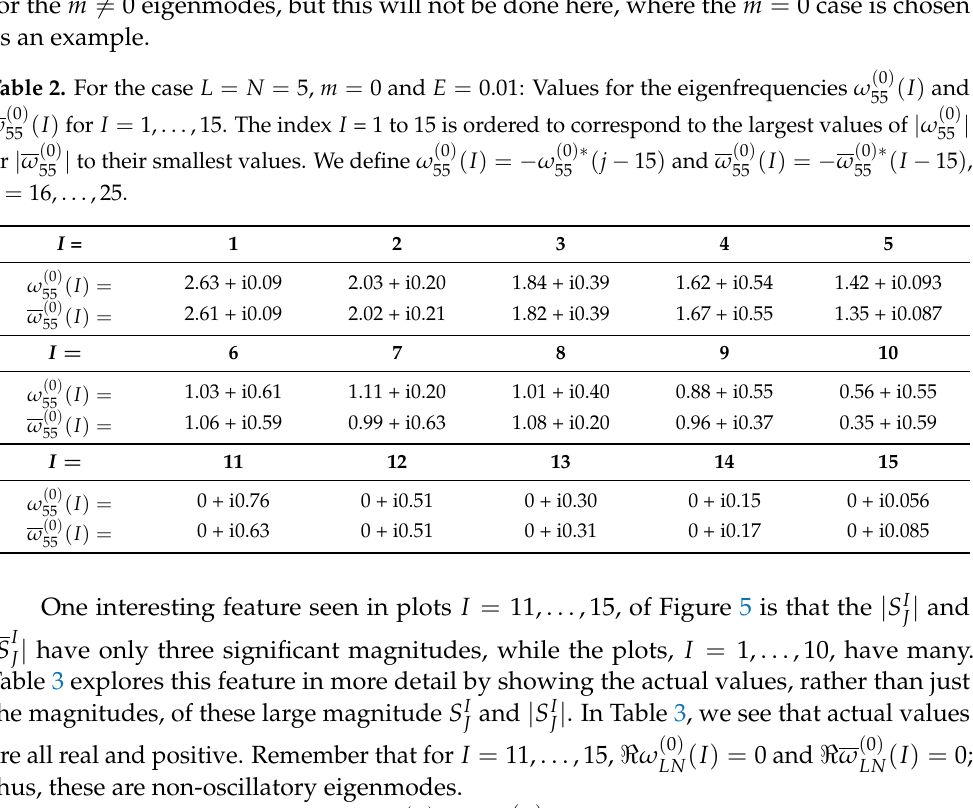
( 0 ) ( I ) and 55 | 55 ( I ) = − ω ( 0 ) ∗ ( I − 15 ) , 55 55